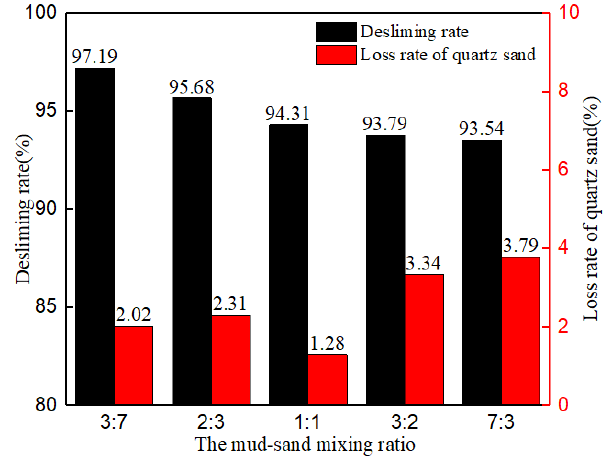
Figure 14. Effect of the mud – sand mixing ratio on desliming performance. From Figure 13, when the mud – sand mixing ratio was 3:7, 2:3 and 1:1, the separation